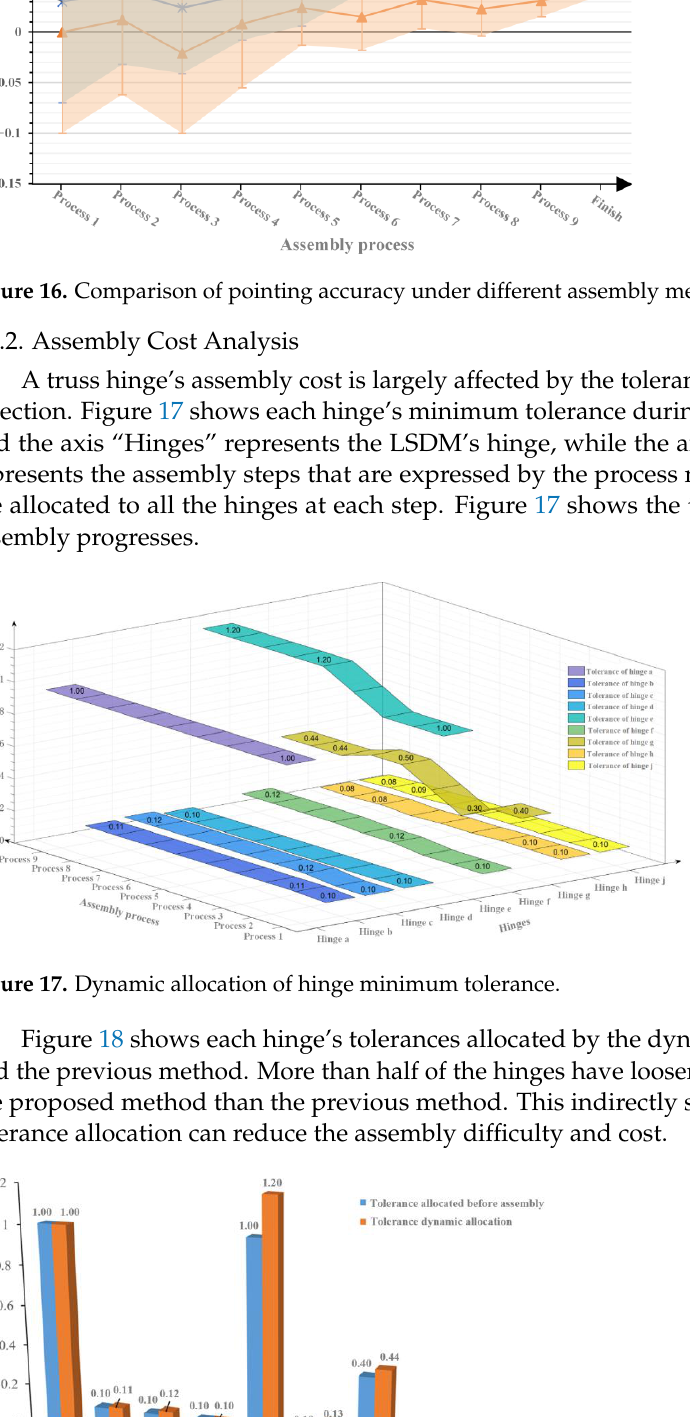
Figure 16. Comparison of pointing accuracy under different assembly methods.